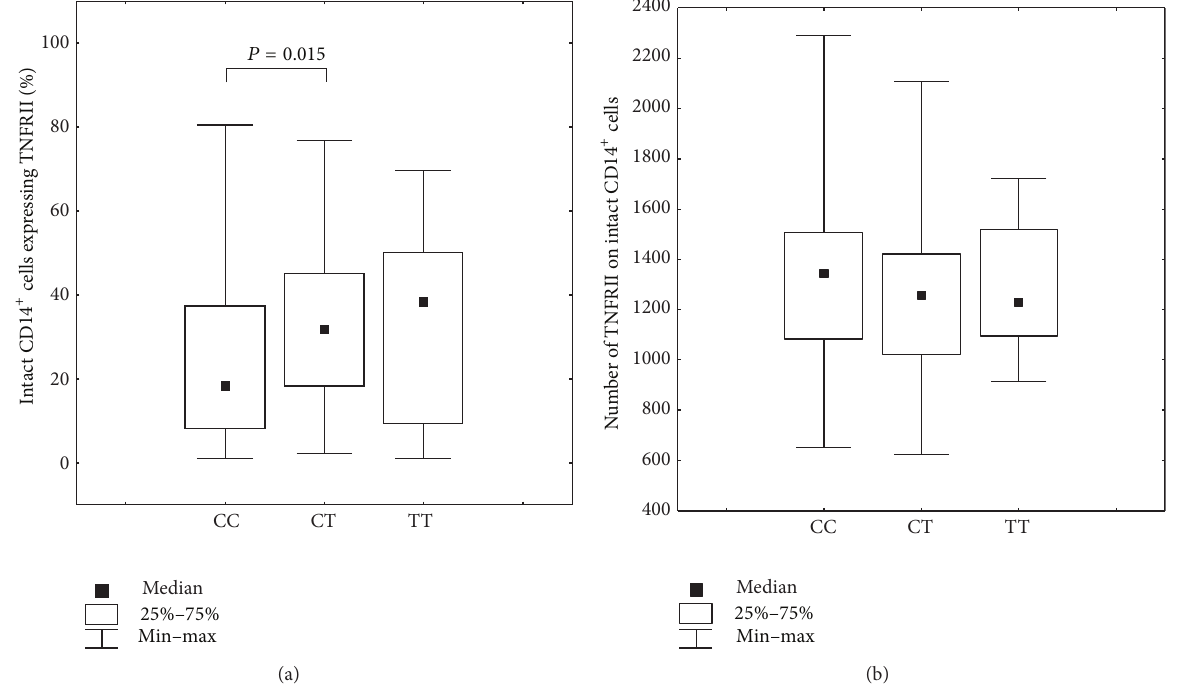
Figure 3: (a) Percentage of CD14 + cells expressing TNFRII in individuals presenting with different SNP TNFRII − 3609C/T (rs590368) genotypes. Kruskall-Wallis 𝐻 test, 𝑃 = 0.041 , Mann-Whitney 𝑈 test: CC versus CT, 𝑃 = 0.015 . (b) Number of membrane-bound TNFRII present on CD14 + monocytes in individuals presenting with different SNP TNFRII − 3609C/T (rs590368)